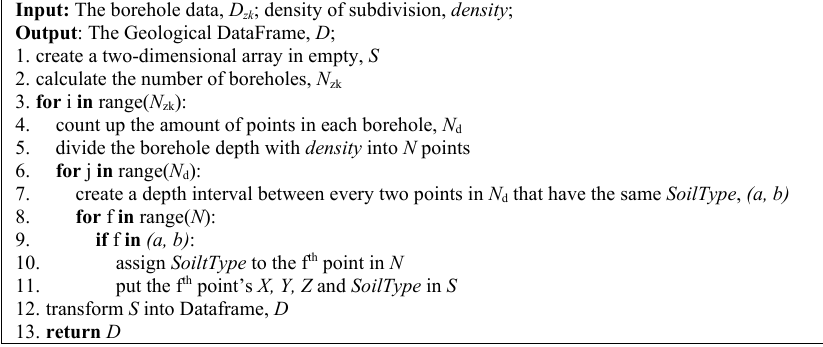
Algorithm 1 . Increasing data density of original geological information